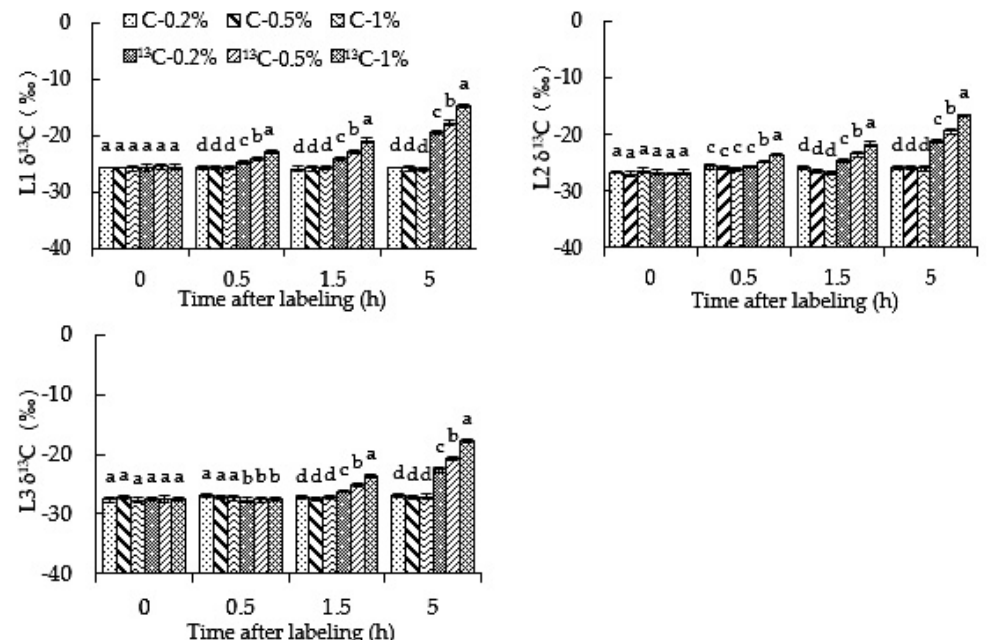
Figure 1. High root-zone 13 CO 2 affects the abundance of 13 C in roots and different aboveground nodes of oriental melon plants. L1 represents the roots, L2 represents the first and second real-leaf and the first and second stems of the plant, and L3 represents other leaves and stems. Standard errors (SEs) of the means are represented by error bars. Different letters in the same row indicate significance at the 0.05 level among treatments.